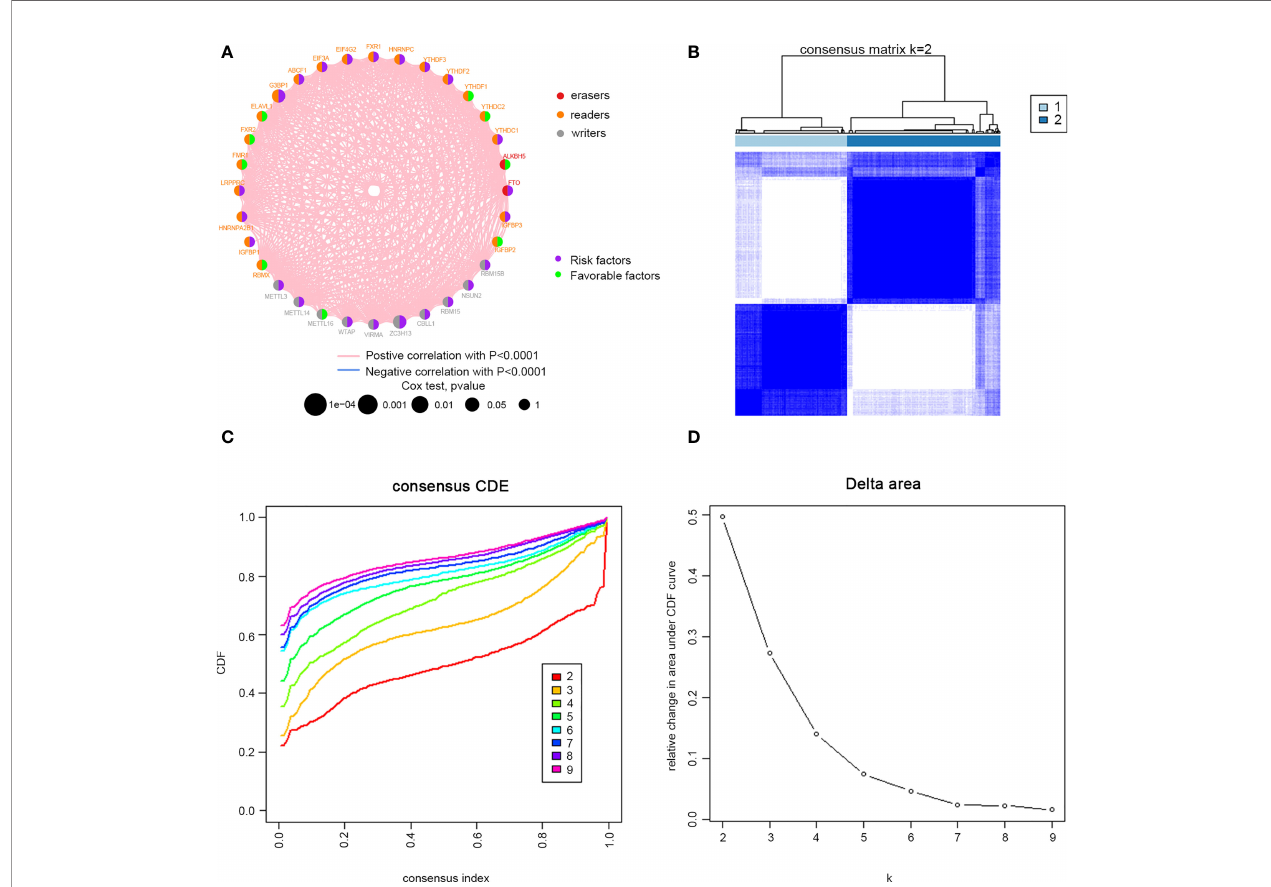
FIGURE 2 | M6A methylation modi fi cation patterns in cervical cancer. (A) Interaction between m6A regulators. Red dots represent erasers, orange dots represent readers, and gray dots represent writers. Pink lines represent positive correlation between m6A regulators, and blue lines represent negative correlation between m6A regulators. The size of each circle represents the prognostic effect of each adjustment factor and is scaled by P value. Purple indicates risk factors, and green indicates favourable factors. Cervical cancer samples were classi fi ed to two m6Aclusters (A and B) according to the ConsensusClusterPlus algorithm. (B) Consensus matrix. (C) CDF graph. (D) Relative change of the area under the CDF curve when k=2 –